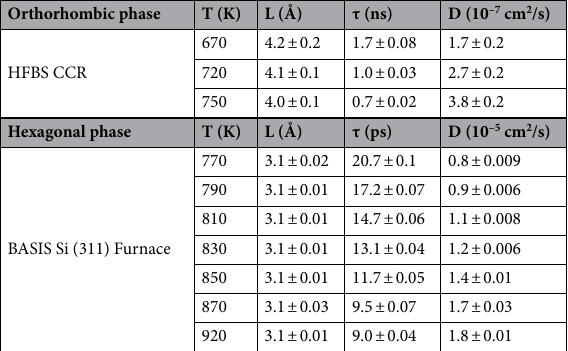
Table 1. Jump lengths, residence times, and diffusion coefficients determined from QENS